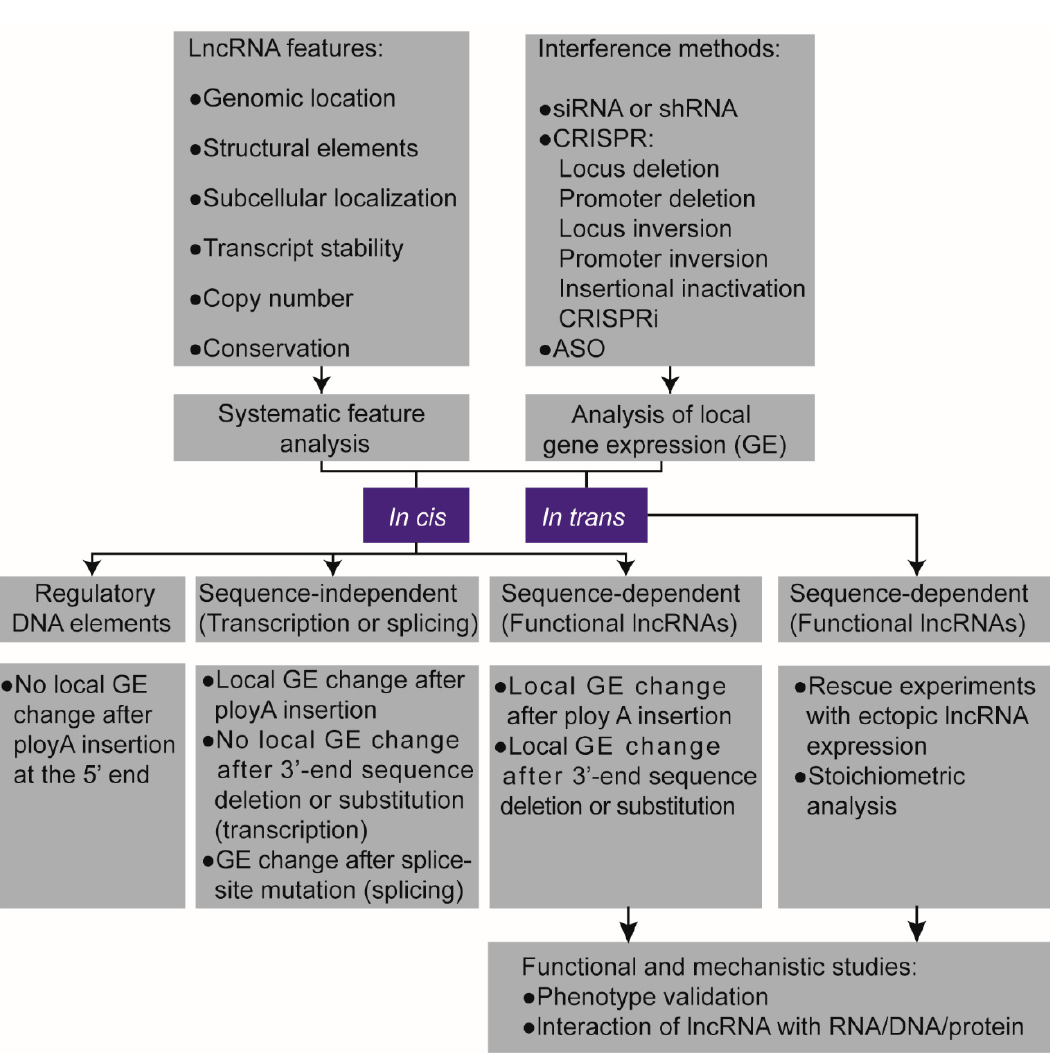
Figure 2. Framework for the functional characterization of lncRNAs. CRISPR: Clustered regularly interspaced short palindromic repeats. ASO: antisense oligonucleotide, lncRNA: long non-coding RNA, siRNA: small interfering RNA, shRNA: short hairpin RNA.